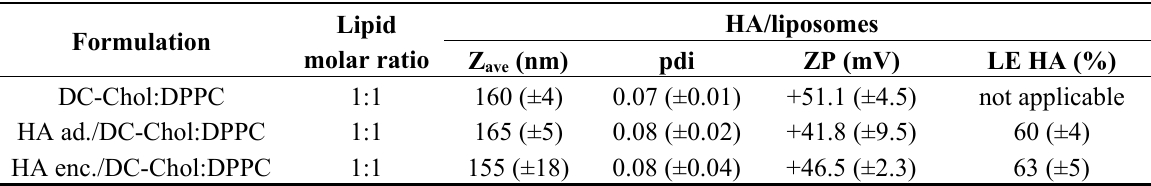
Table 1. Physicochemical characteristics of DC-Chol:DPPC liposomes before and after hemagglutinin (HA) loading.